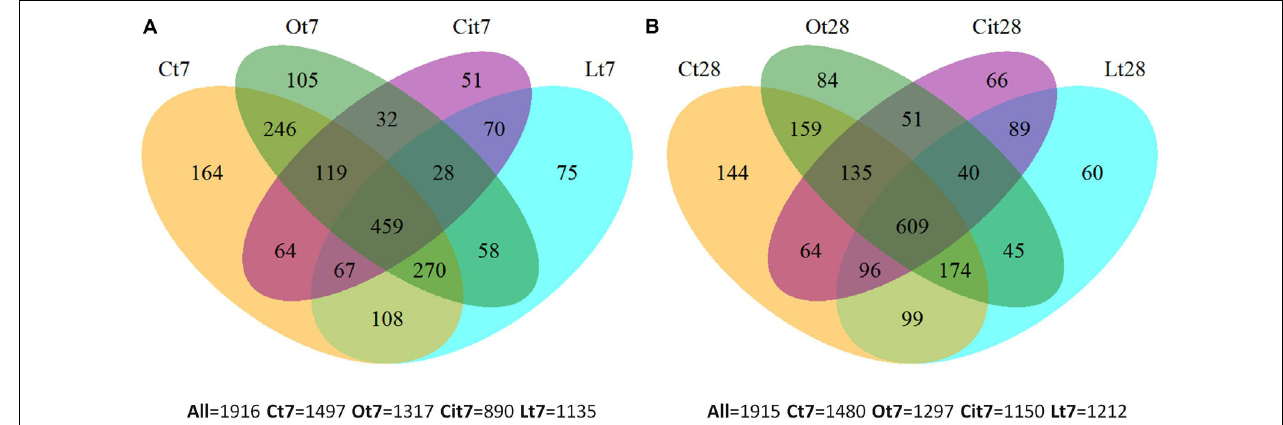
FIGURE 5 | Venn diagrams of unique and shared OTUs among samples at (A) 7 and (B) 28 days. C, control sample; L, lactic acid treated sample; O, oxalic acid treated sample; Ci, citric acid treated sample.